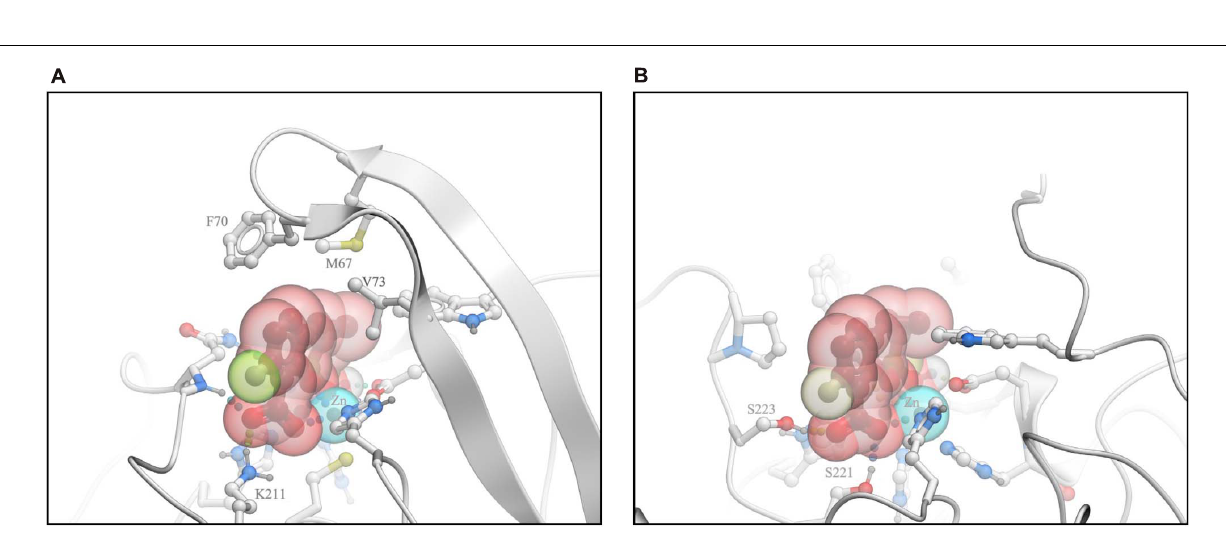
FIGURE 5 | Analysis of interactions of QPX7728 with NDM-1 and L1 B-Lactamases. (A) The crystal structure of QPX7728/NDM-1 complex. (B) Model of the putative QPX7728/L1 complex. Modified from Lomovskaya et al.